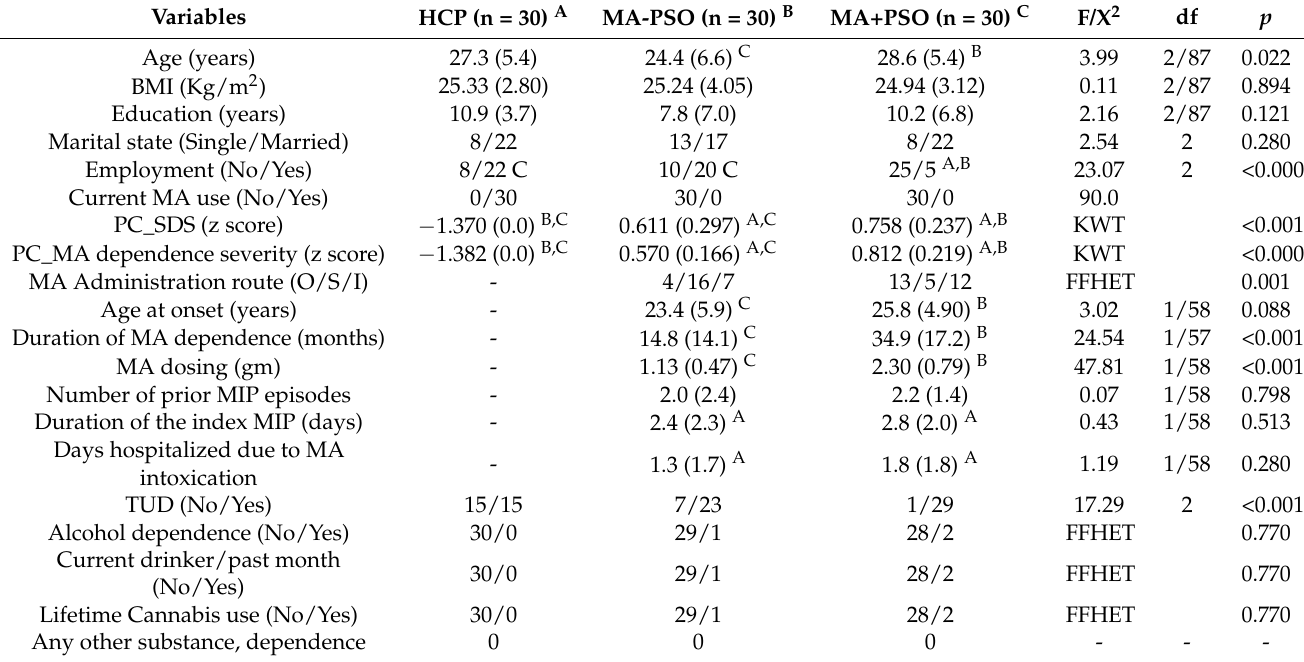
Table 1. Socio-demographic and methamphetamine abuse (MA) data in healthy control partici- pants (HCP) and MA patients classified as those with (MA+PSO) and without (MA-PSO) increased psychotic symptoms and oxidative stress